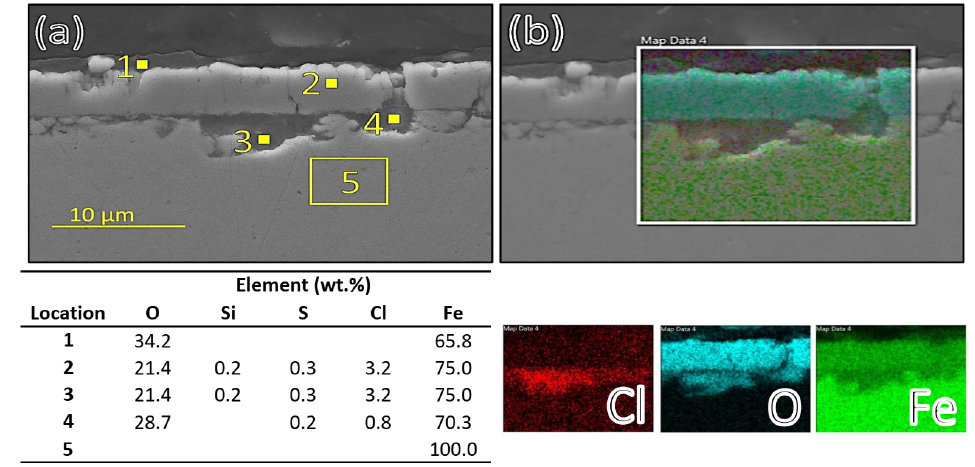
Figure 8. Cross-section of tested carbon-steel sample 1, three cm from the inlet of the first reactor